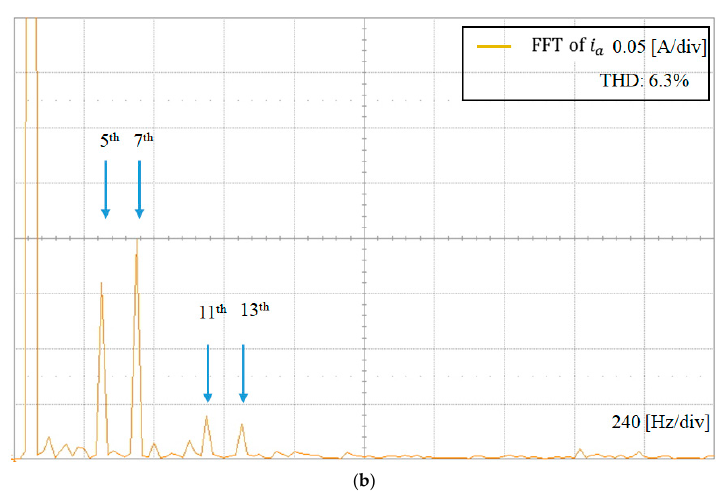
Figure 16. Experimental results of the inverter currents for the conventional PI control scheme under distorted grid condition. ( a ) Phase current waveforms; ( b ) FFT result of a -phase current.